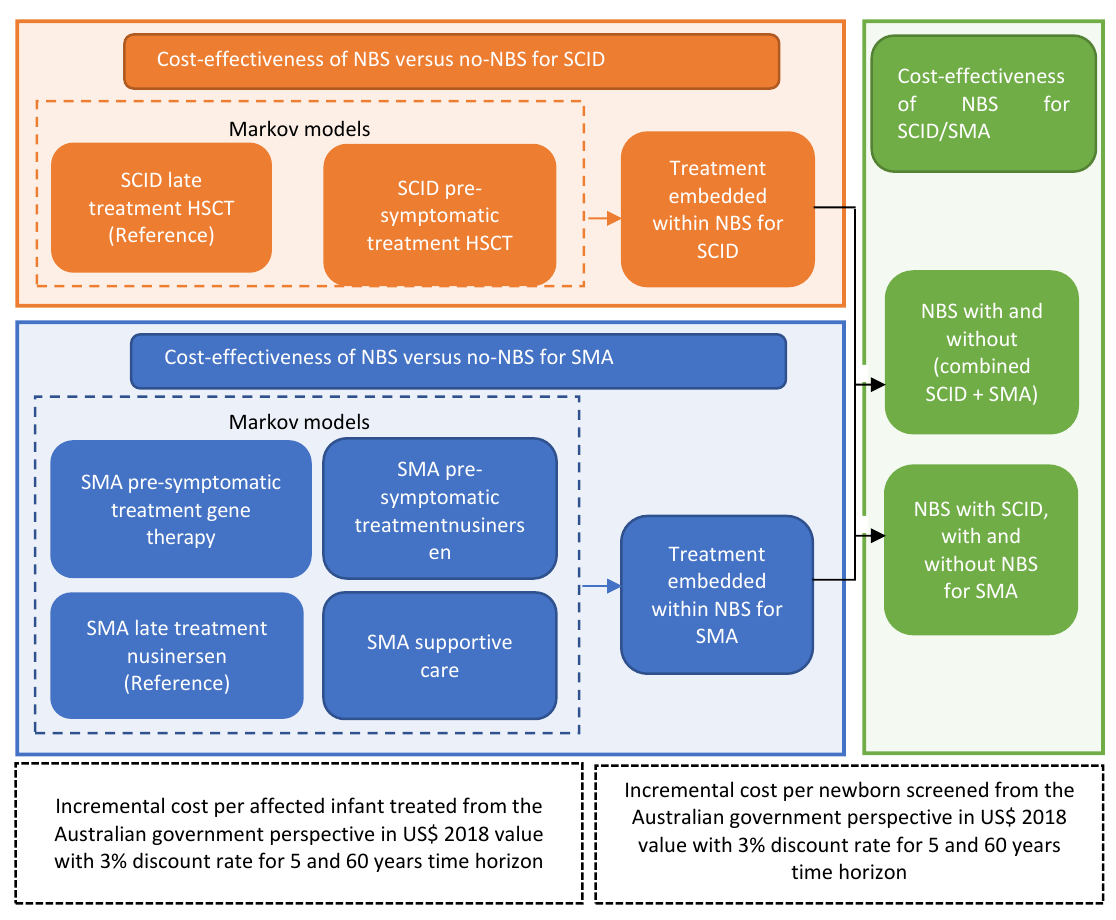
Figure 1. Analytical framework for SCID and SMA newborn screening and treatment strategies.